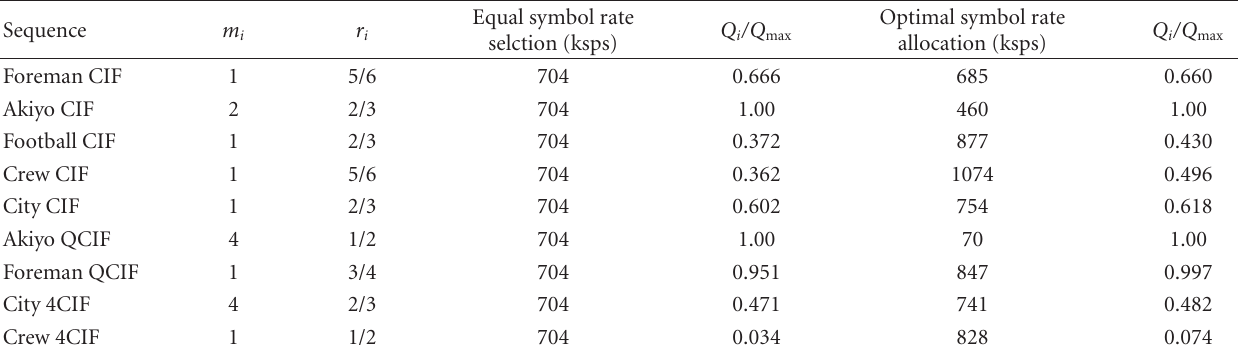
Table 2: Allocation of symbols in an OFDM frame for unicast at t = 30fps.